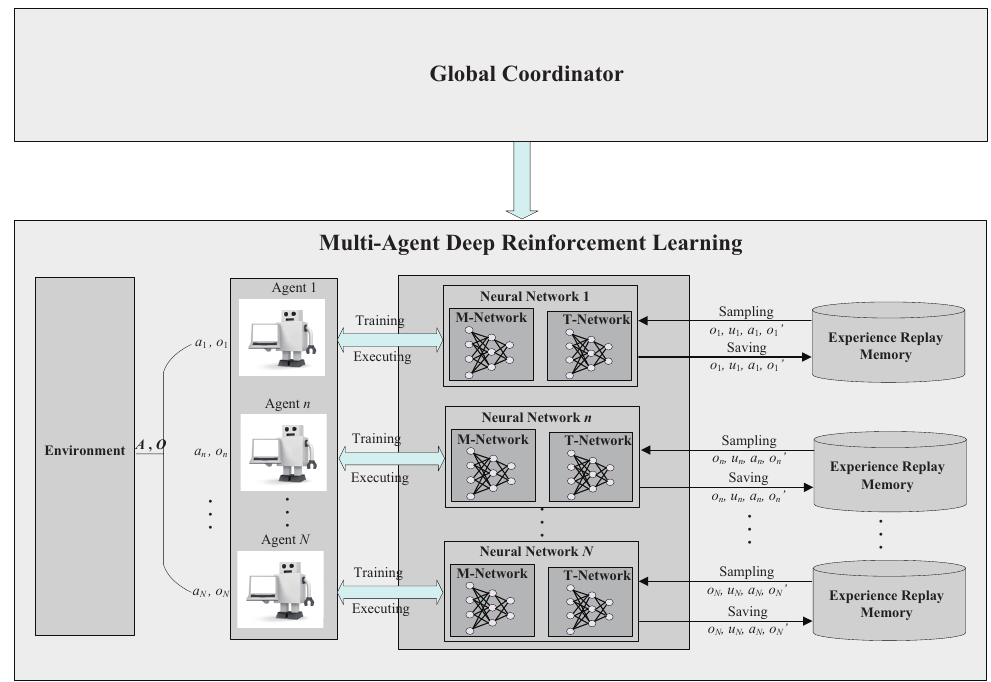
Figure 2. Structure of proposed decentralized multi-agent deep reinforcement learning model. Algorithm 1 is the explanation on the proposed DRL-based optimization